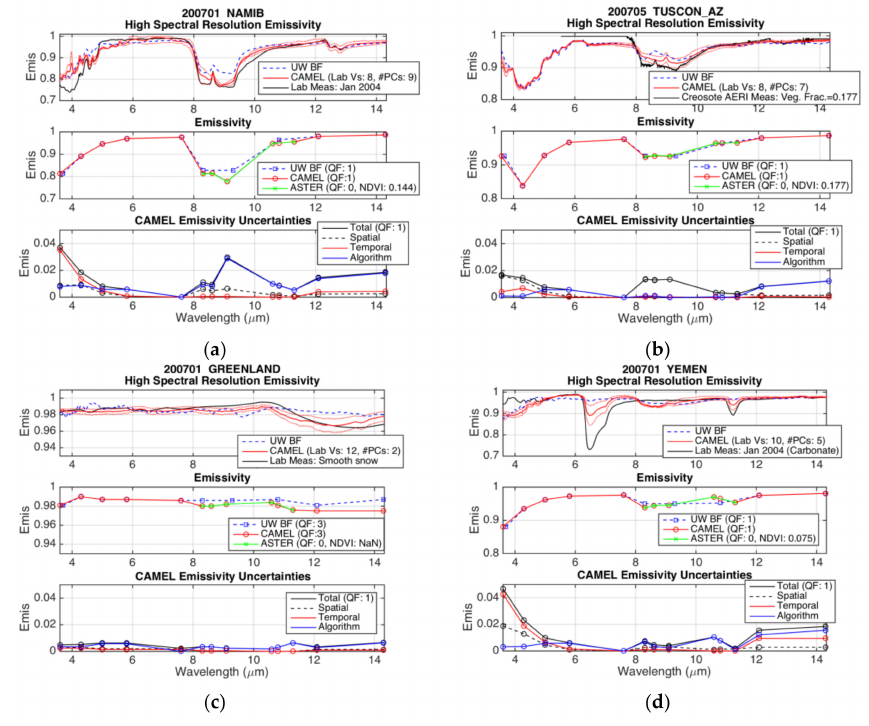
Figure 3. Emissivity at ( a ) January 2007 Namib Desert ( − 24.25N, 15.25E); ( b ) May 2007 Tucson, AZ (32.01N, − 110.77E); ( c ) January 2007 Greenland (72.57N, − 38.45E); and ( d ) January 2007 Yemen (19.15N, 55.57E) case sites. HSR emissivity from UW BF (blue dashed), lab measurements (black), and CAMEL (red solid with dotted uncertainty) are shown in top row panels. UW BF (blue squares, dashed), ASTER (green x’s, solid), and CAMEL (red circles, solid) emissivity are shown in middle row panels. CAMEL total (black solid), spatial (black dash), temporal (red), and algorithm (blue) uncertainty components are shown in bottom panels. Legend in middle and bottom panel include quality flags (QF) for the different products as well as ASTER normalized difference vegetation index (NDVI). The version number (Vs) of the laboratory dataset and the number of principal components (#PCs) used in the CAMEL HSR Algorithm are included in the legend of the top